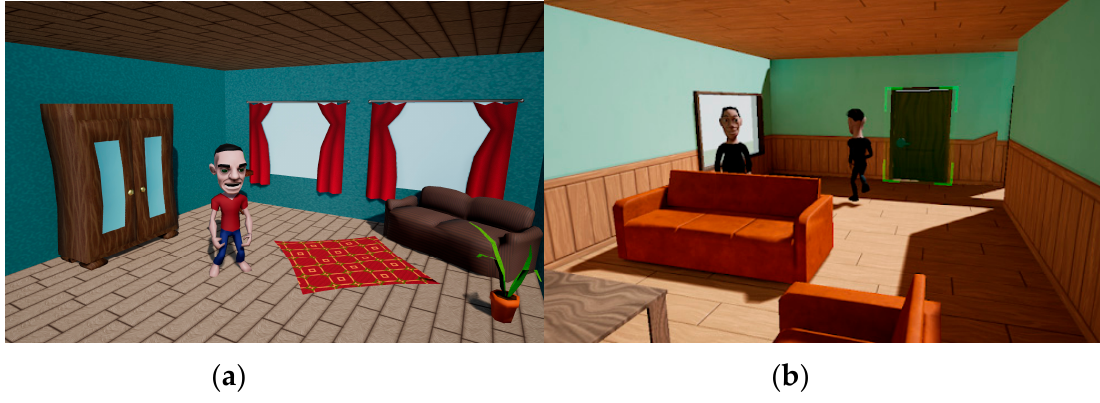
Figure 6. ( a ) Initial user experience (UX) concept. ( b ) Final UX design.